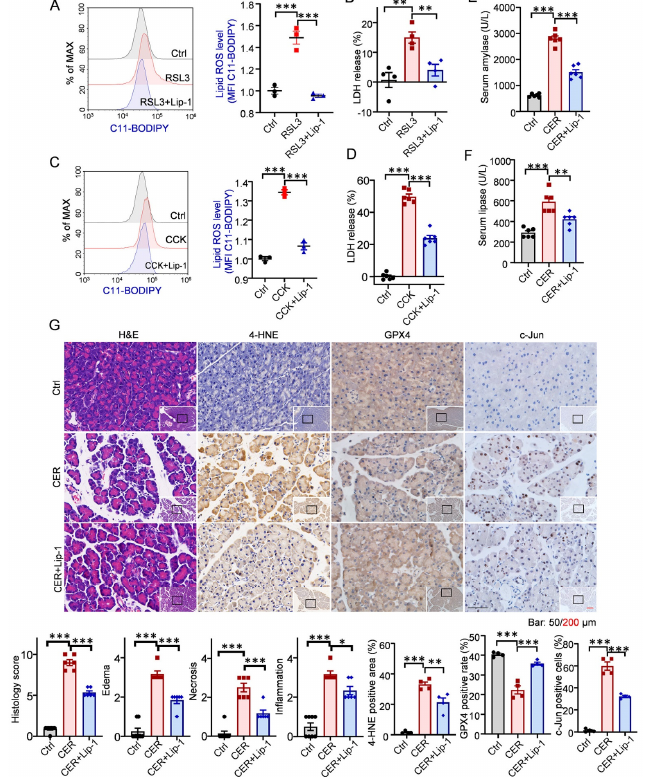
Figure 2. Blocking ferroptosis alleviated the experimental acute pancreatitis and inhibited Jun. ( A – D ) The 266-6 cells were treated with RSL3 (200 nM) or cholecystokinin (CCK) (5 μ M) with or without liproxstatin-1 (Lip-1, 10 μ M, ferroptosis inhibitor) for 6 h; lipid reactive oxygen species (ROS) levels